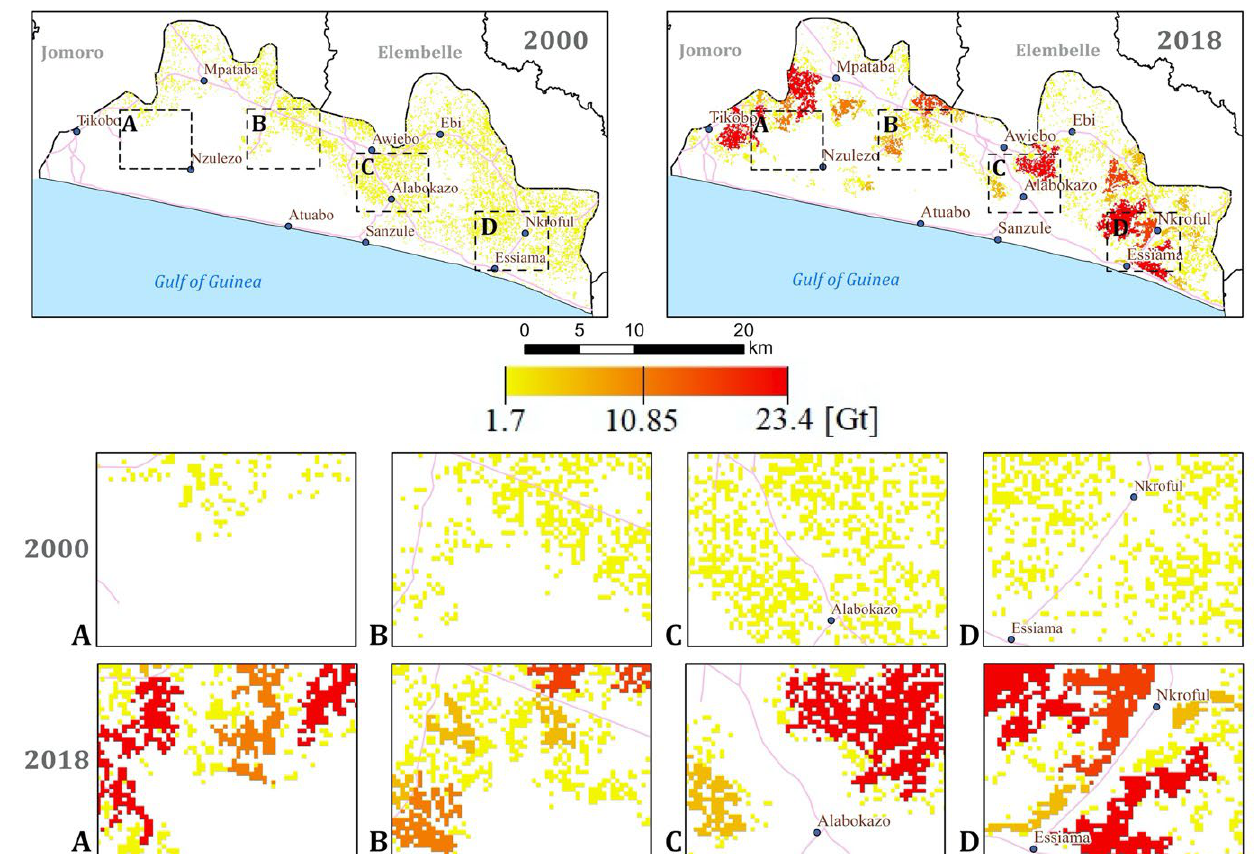
Figure 5. Quantities and distribution of food supply from cassava across the landscape in 2000 and 2018; ( A – D ) compares the spatial and temporal distribution of cassava food-crop supply potential for segments of the landscape.